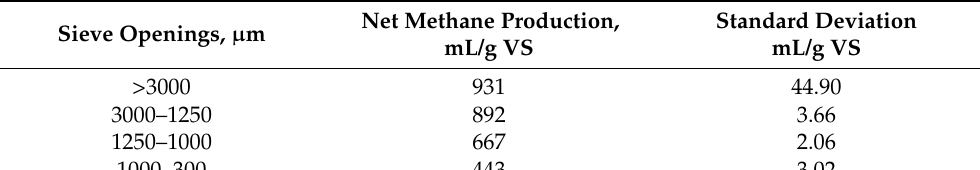
Table 1. Total net methane production for solid samples produced from sieves with openings of different sizes, in mL/g VS.